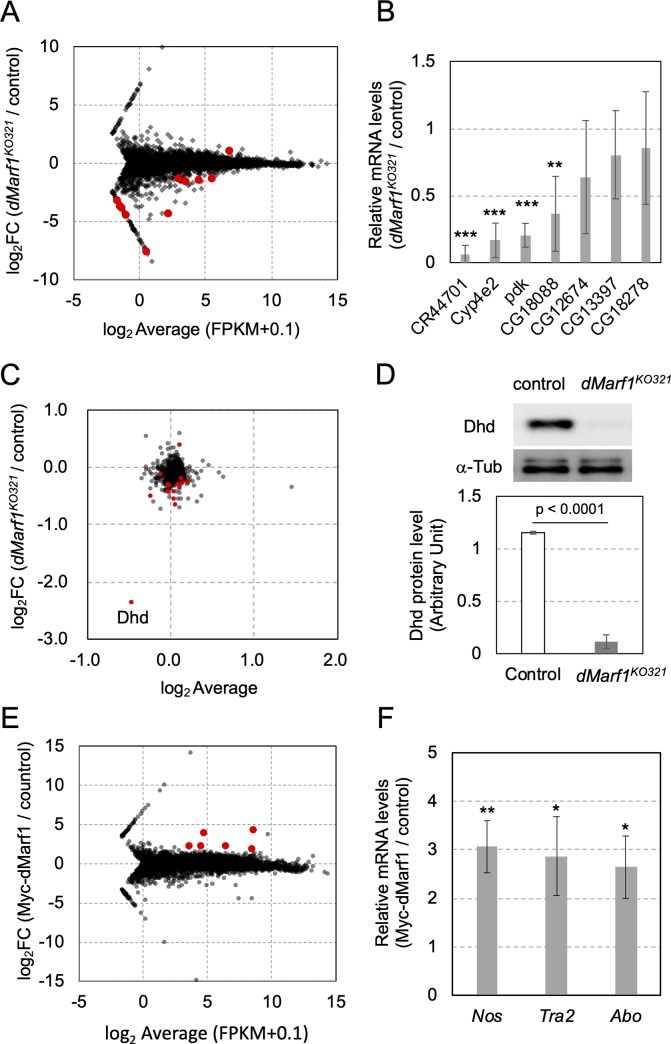
Global analysis of gene expression in dMarf1KO321 ovaries and dMarf1-bound mRNA in Myc-dMarf1 expressing ovaries.(A) MA plot for mRNA-seq analysis. The average RPKM (Reads Per kilobase per Million reads) values for each gene in dMarf1KO321 and the control ovaries are plotted on the X-axis. The log2-fold change in the expression of each gene in dMarf1KO321 compared to that in the control ovaries are plotted on the Y-axis. Red dots indicate genes whose expressions are significantly different between dMarf1KO321 mutant and the control ovaries (p-value < 0.0001). (B) qRT-PCR validation of differentially expressed genes between the control and dMarf1KO321 ovaries. Values represent the mean and standard deviation of three replicates. The significant differences of student’s t-test are indicated by ** (p-value < 0.01) or *** (p-value < 0.001). (C) MA plot for quantitative proteome analysis of stage 14 egg chambers. The average log2 values in dMarf1KO321 mutant and the control ovaries for each detected protein are plotted on the X-axis. The log2-fold changes of each detected protein in dMarf1KO321 mutant compared to that in the control ovaries are plotted on the Y-axis. Red dots indicate proteins that show significantly different expression levels between the mutant and the control ovaries (p-value < 0.05). (D) Western blot showing Dhd expression in stage 14 dMarf1KO321 egg chambers and control (upper panel). The band intensity represents the mean of three biological replicates. The mean and standard deviation are shown in the lower panel (p < 0.0001; Student’s t-test). α-Tubulin was used as the loading control. (E) MA plot for dMarf1-bound RNA. RNAs bound to Myc-dMarf1 were immunoprecipitated and analyzed by next-generation sequencing. The average RPKM values of each gene whose transcript bound to dMarf1 and the control beads are plotted on the X-axis. The log2-fold change of each gene whose transcript bound to dMarf1 compared to control are plotted on the Y-axis. Red dots indicate genes whose transcripts are significantly enriched with dMarf1 (p-value < 0.005, and log2-fold change > 1.8). (F) qRT-PCR validation of enriched mRNAs in Myc-dMarf1 between the control and dMarf1KO321 ovaries. Values represent the mean and standard deviation of three replicates. The significant differences of student’s t-test are indicated by * (p-value < 0.05) or ** (p-value < 0.01).